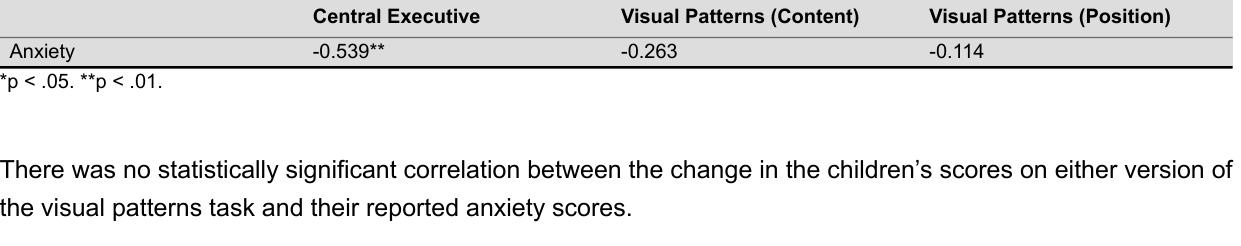
The correlation between mathematics anxiety and change in performance on the two versions of the working memory tasks. -0.114-0.263-0.539**Anxiety *p < .05. **p < .01.